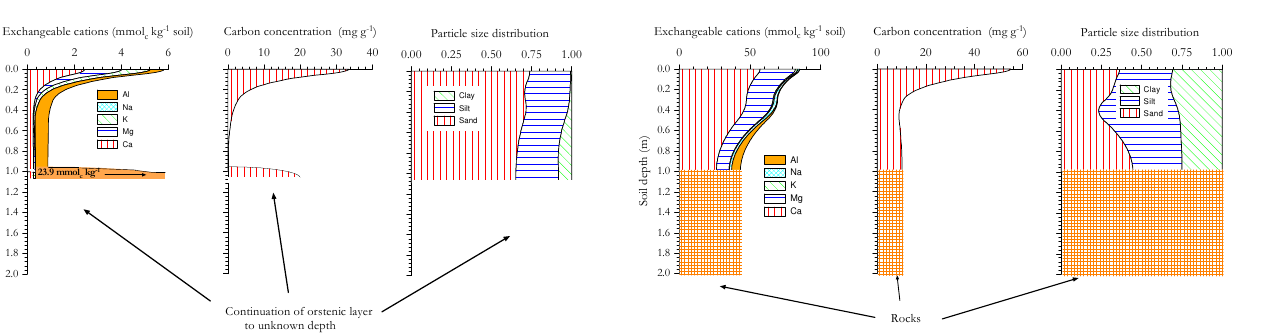
Fig. 14 Fig. 14. Profiles of exchangeable cations, soil carbon and texture for a Ortsteinc Podzol (oxyaquic) in Colombia (ZAR-01).